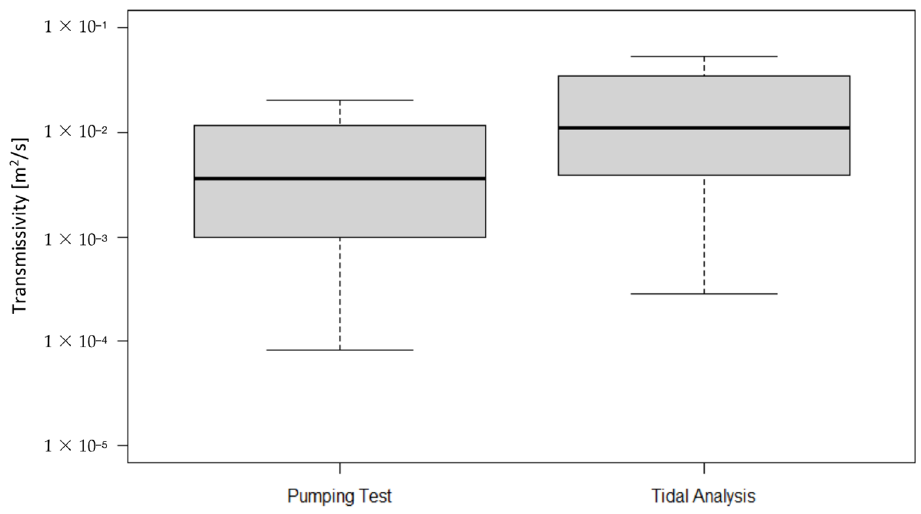
Figure 8. Comparison of calculated transmissivity [m 2 /s] values from pumping tests interpretations and tidal attenuation method through Box and Whisker